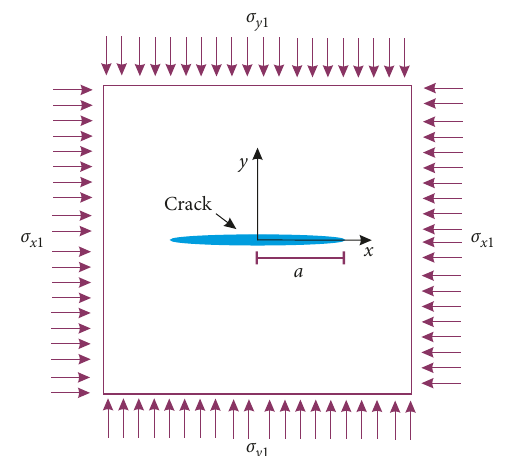
Figure 4: Numerical model of the type I fracture model with pore pressure. Table 1: The parameter table.